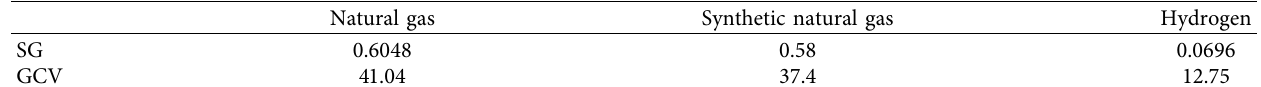
Table 1: SG and GCV of gas sources.